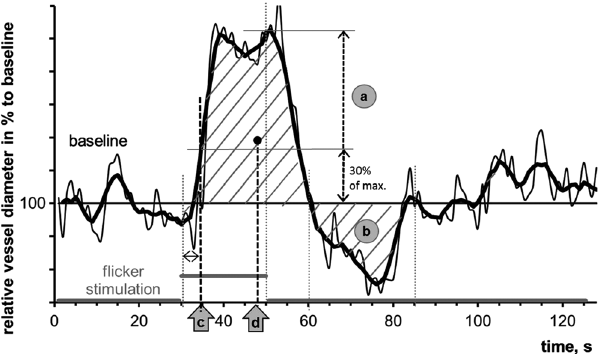
Figure 1. Some parameters of retinal vessel reaction to flicker reported in the study. Clarification of other parameters elsewhere 17 . The thin black line shows the median vessel diameter from the 3 flicker cycles. The superimposed solid black line illustrates the running median (4 s frame and the corresponding back shift) used to smooth the data. All vessel parameters were calculated using the values from this running median line (see detailed explanation in the text). The following parameters were derived from the flicker curve: ( a ) mean maximal dilation in response to flicker, [% to the baseline]; ( b ) area under the reaction curve after